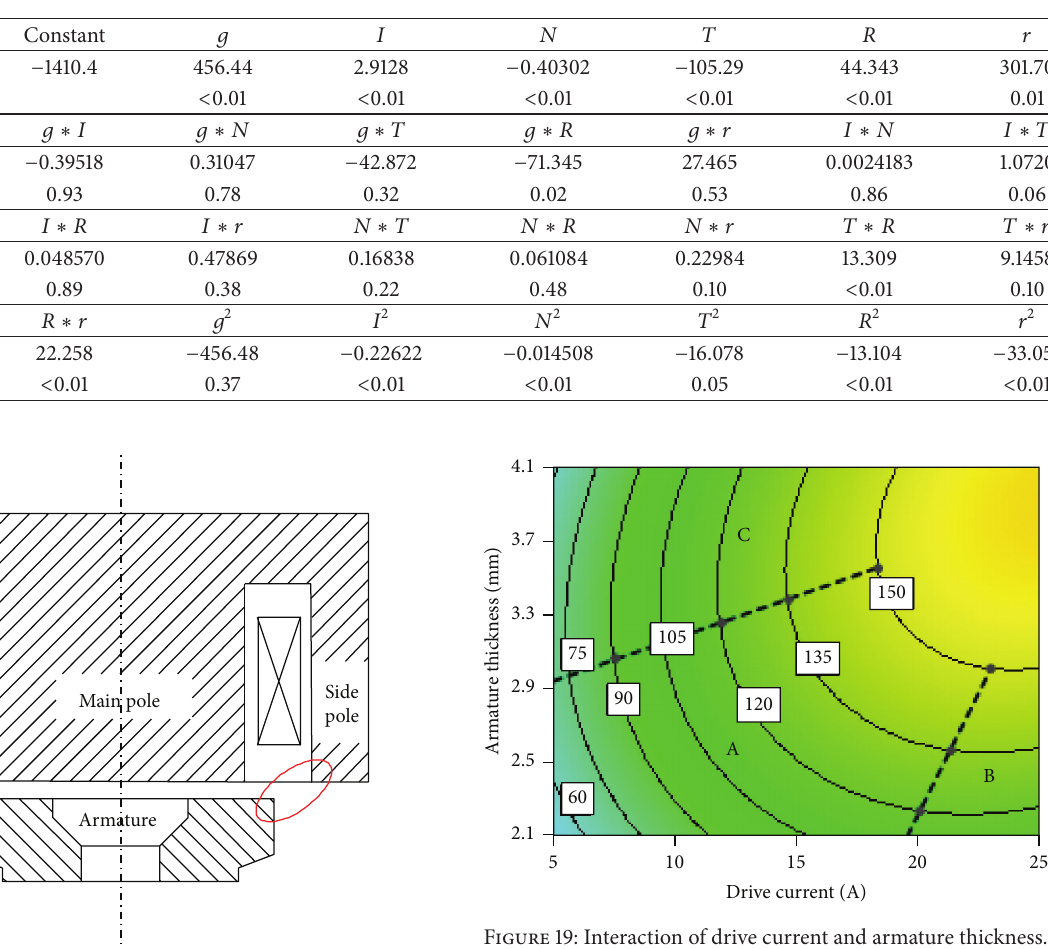
Table 4: The coefficients and their significant values of model.